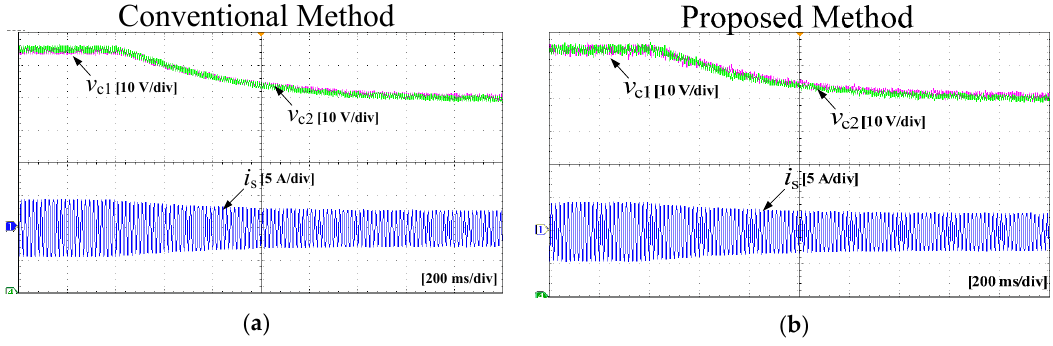
Figure 24. Experimental results of capacitor voltages ( v c1 , v c2 ) and source current with step change of dc voltage from 150 V to 120 V obtained by ( a ) conventional method and ( b ) proposed method.